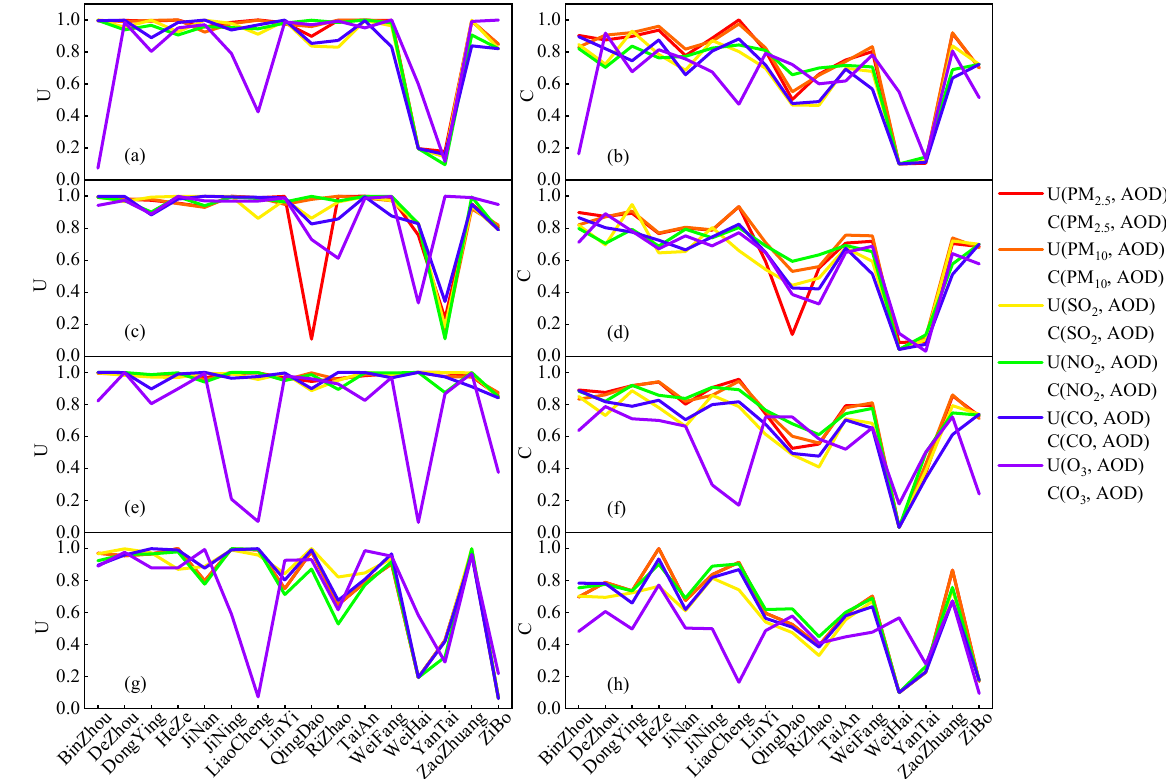
Figure 9. Coupling degree and coupling coordination degree between AOD and each pollution in- dicator in spring ( a , b ), summer ( c , d ), autumn ( e , f ) and winter ( g , h ).